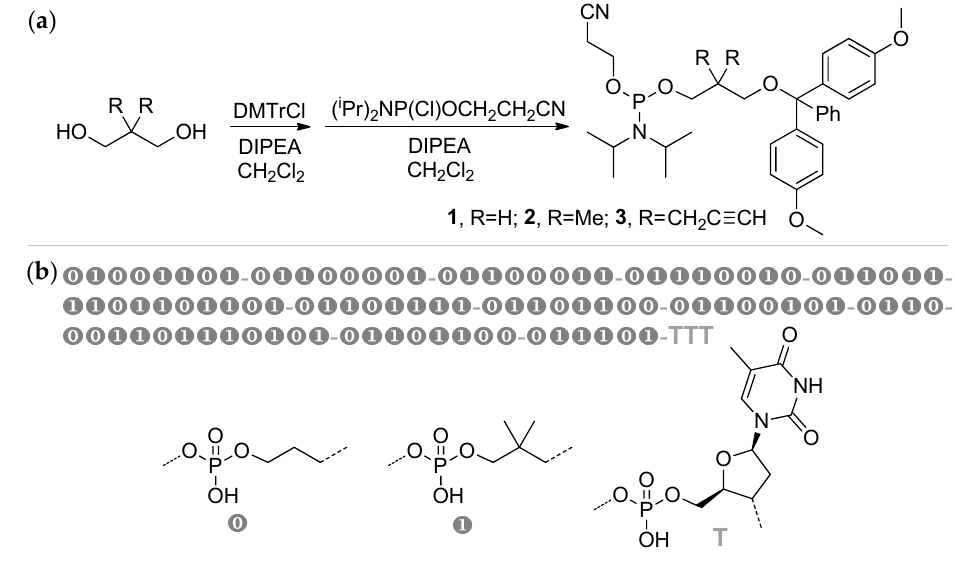
Scheme 29. ( a ) Synthesis of the phosphoramidite monomers [113]. ( b ) The sequence-defined copolymer with DP n > 100 and the structures of the comonomer units [109].